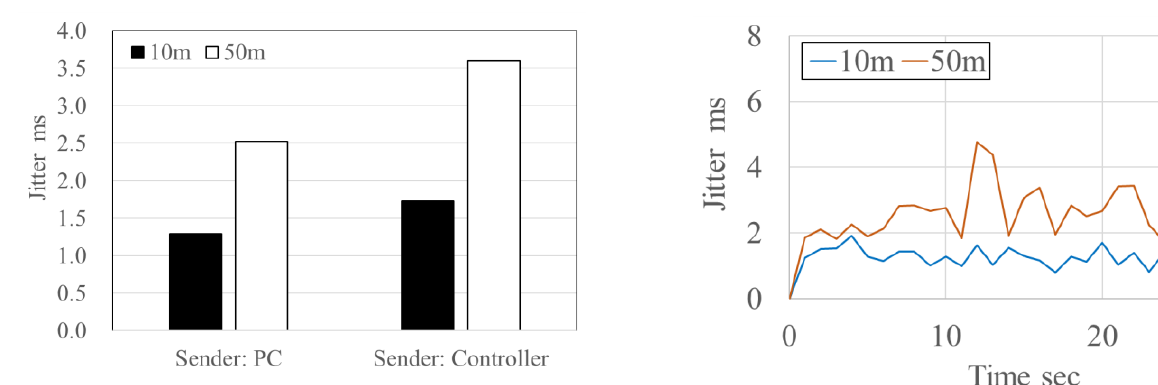
Figure 19. Average UDP jitter results when the distance between the PC and the controller is 10 m and 50 m. Black bar is 10 m results, and white bar is 50 m results.